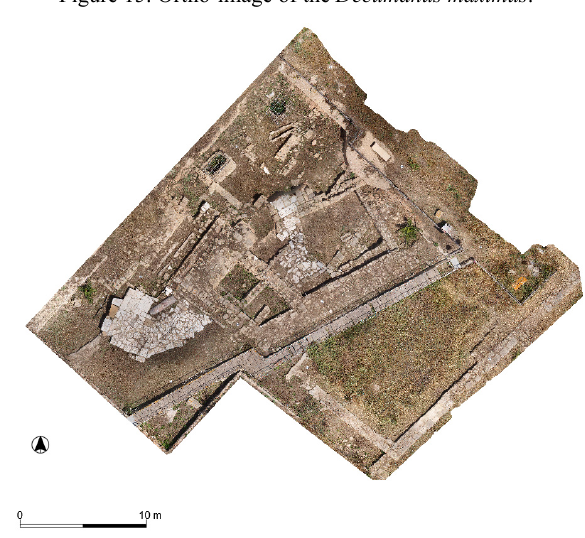
Figure 15. Ortho-image of the Decumanus maximus .